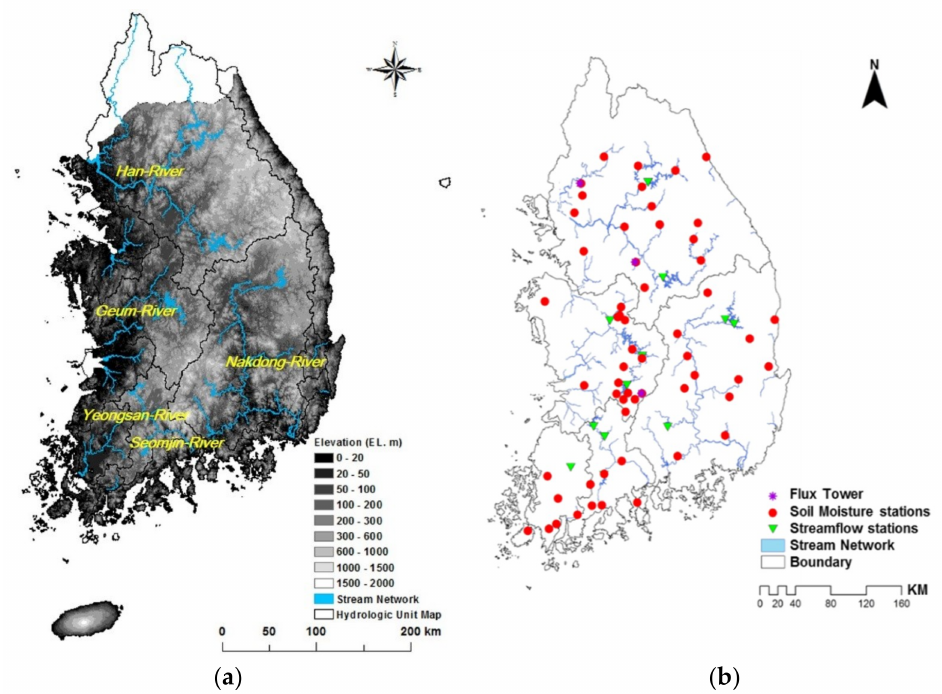
Figure 2. Study area of South Korea: ( a ) rivers and digital elevation model (DEM) and ( b ) locations of the streamflow and soil moisture (SM) monitoring stations and flux towers in South